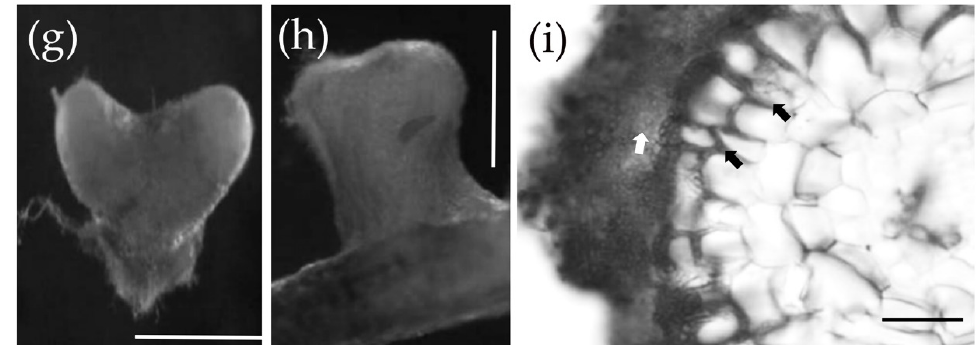
Figure 3. The ectomycorrhizal (ECM) formation process between P. massoniana and S. bovinus . ( a , b ) At 7 days post-inoculation (dpi): scale bars = 5 mm and 500 μ m, respectively. The white arrow indicates hyphae wrapped around the root system; black arrows indicate the intercellular mycelium. ( c , d ) At 14 dpi: scale bars = 1 mm and 100 μ m, respectively. The white arrow indicates hyphae wrapped around the root system; black arrows indicate the developing Hartig net. ( e , f ) At 21 dpi: scale bars = 1 mm and 50 μ m, respectively. The white arrow in ( e ) indicates hyphae wrapped around the root system. The white arrow in ( f ) indicates the developing mantle and black arrows indicate the Hartig net. ( g – i ) At 28 dpi: scale bars = 1 mm, 500 μ m, and 50 μ m, respectively. ( g ) Dichotomous branching hypha, ( h ) swollen hypha. ( i ) Cross-section of the root: the white arrow indicates the mantle and black arrows indicate the Hartig net.